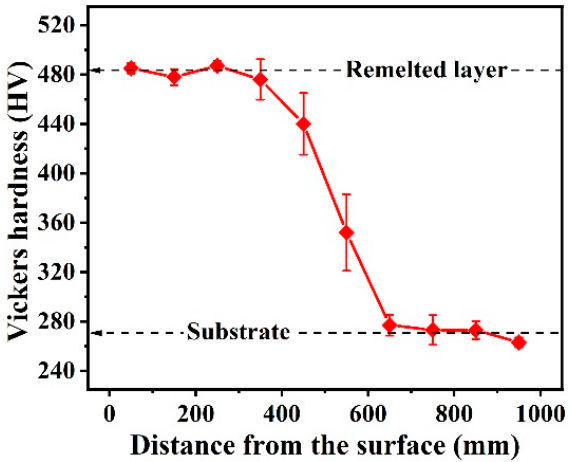
Figure 5. Cross-sectional microhardness distribution of the Al 0.65 CoCrFeNi specimen after LR.